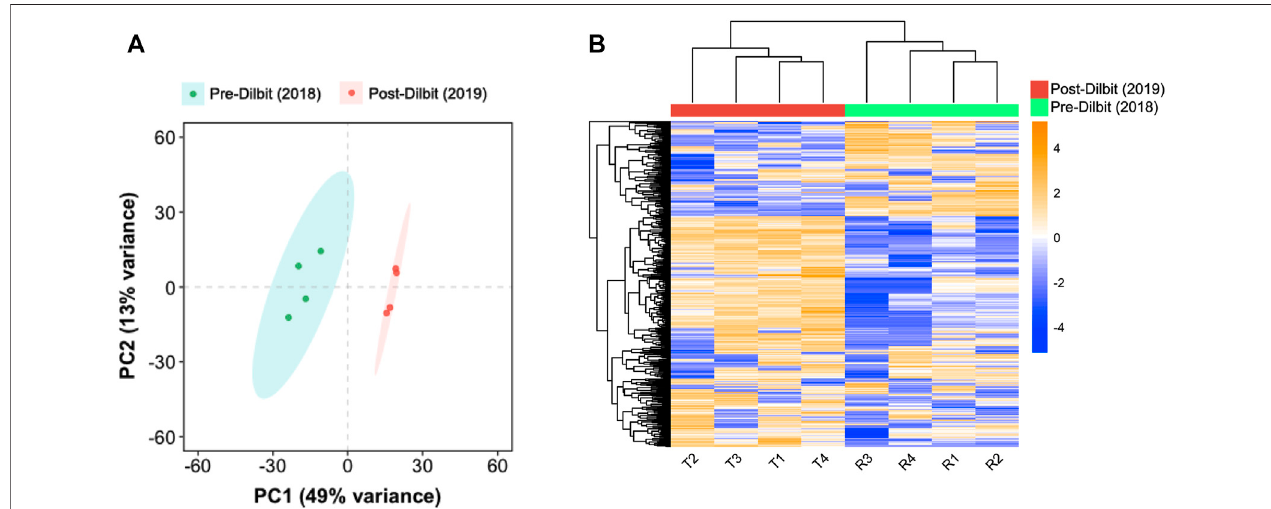
FIGURE2| Comparisonofpre-andpost-dilbitexposedlakecharrusing (A) principalcomponentanalysisoftranscriptome-widecountdataand (B) unsupervised hierarchical clustering of the top 500 most variable transcripts.